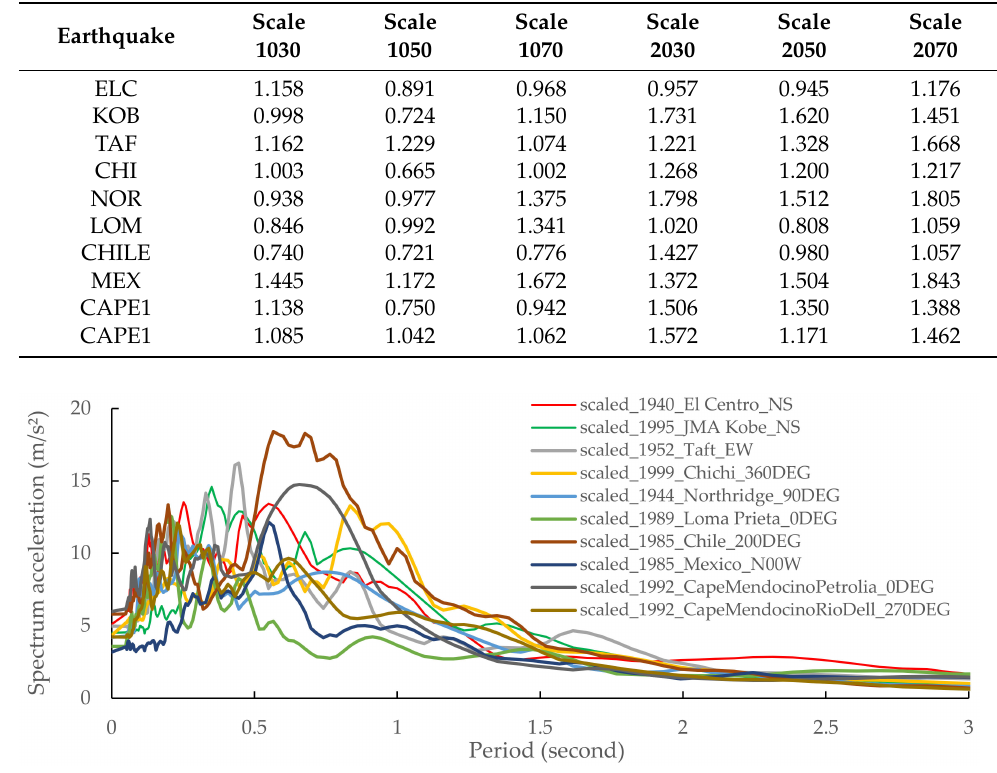
Figure 14. Acceleration response spectrum of original earthquake ground